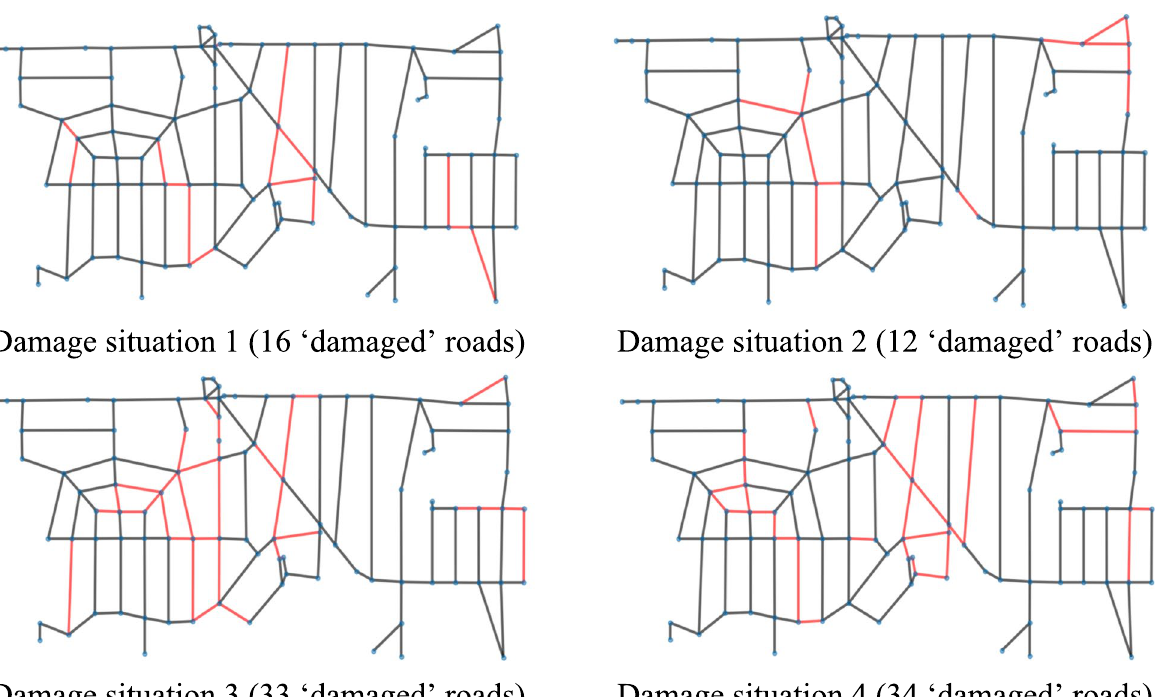
Fig. 15 Four different flood situations simulated by the SIS network diffusion model (road section indicated as red are submerged under flood)